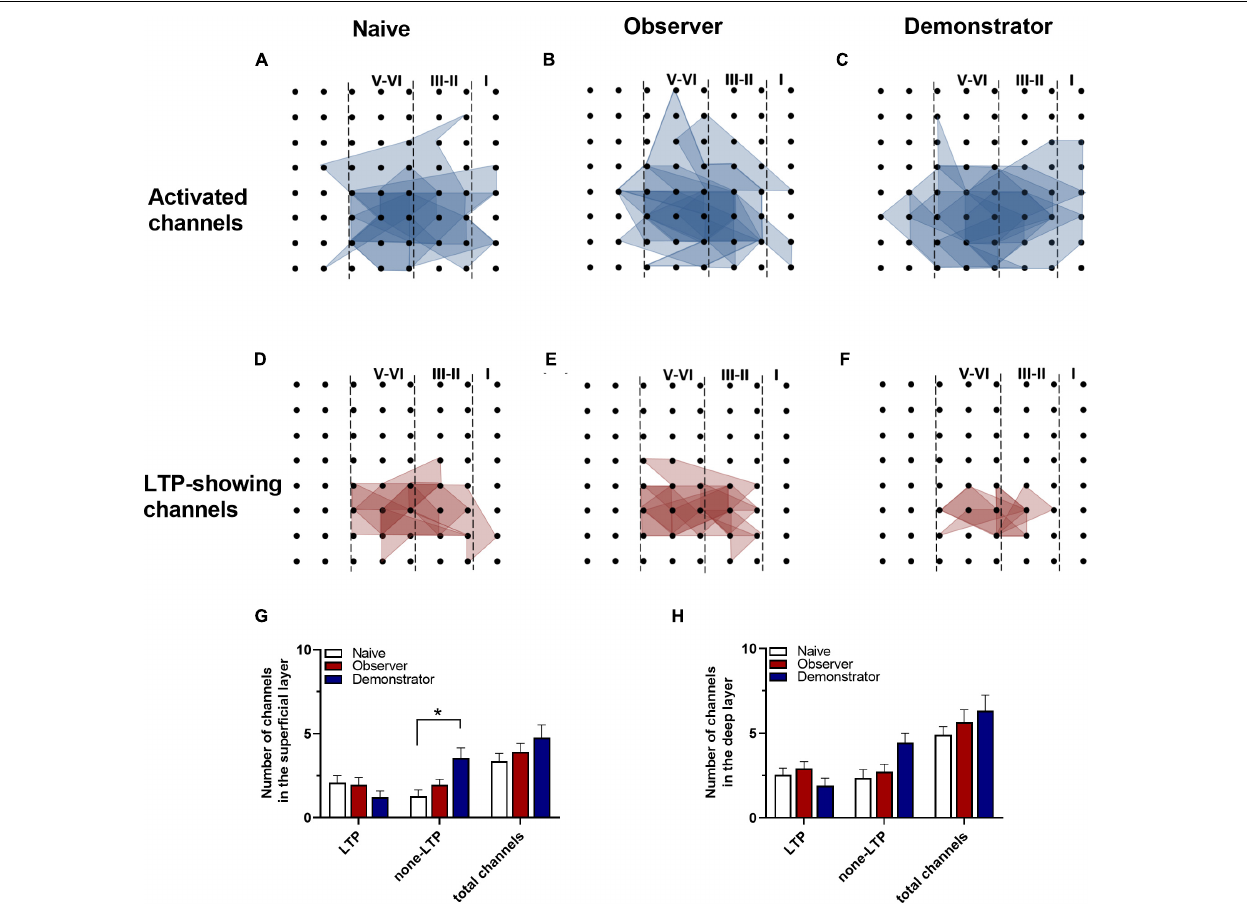
FIGURE 4 | Spatial analysis on LTP distribution in aIC. (A–F) The polygonal diagram of activated (blue) and LTD-showing (red) channels within aIC in naïve (A,D) , observer (B,E) , and demonstrator mice (C,F) . (G,H) The average number of all channels of naïve, observer, and demonstrator mice in the superficial (G) and deep layers (H) . Data are shown as mean ± SEM (Naïve n = 7 slices of 6 mice, observer n = 13 slices of 9 mice, and demonstrator n = 6 slices of 6 mice) and compared by two-way ANOVA analysis followed by unpaired t -test,* p < 0.05, vs. naïve.